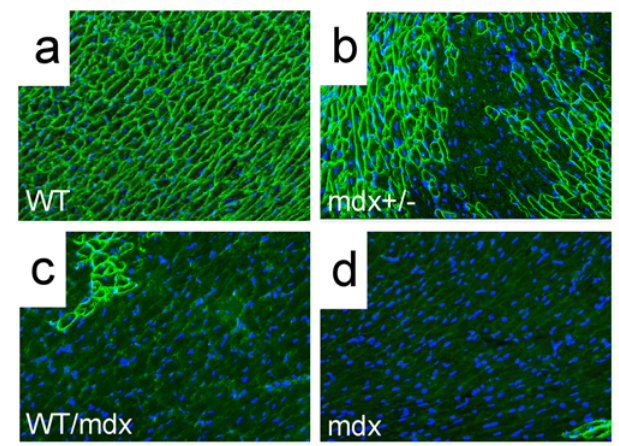
Figure 6. Dystrophin is detected in cardiomyocytes in the WT/ mdx chimeric heart. Dystrophin immunofluorescence (green) was performed on sections of WT (a), mdx + / 2 (b), 10–30% WT/mdx chimeric (c) and mdx (d) heart (400 6 ). Note the presence of revertant cardiomyocytes in (d, bottom right). DAPI (blue) demarcates nuclei. Experiments were performed with 3 animals (n=3) per group (WT, mdx + / 2 , 10–30% WT/mdx and mdx).